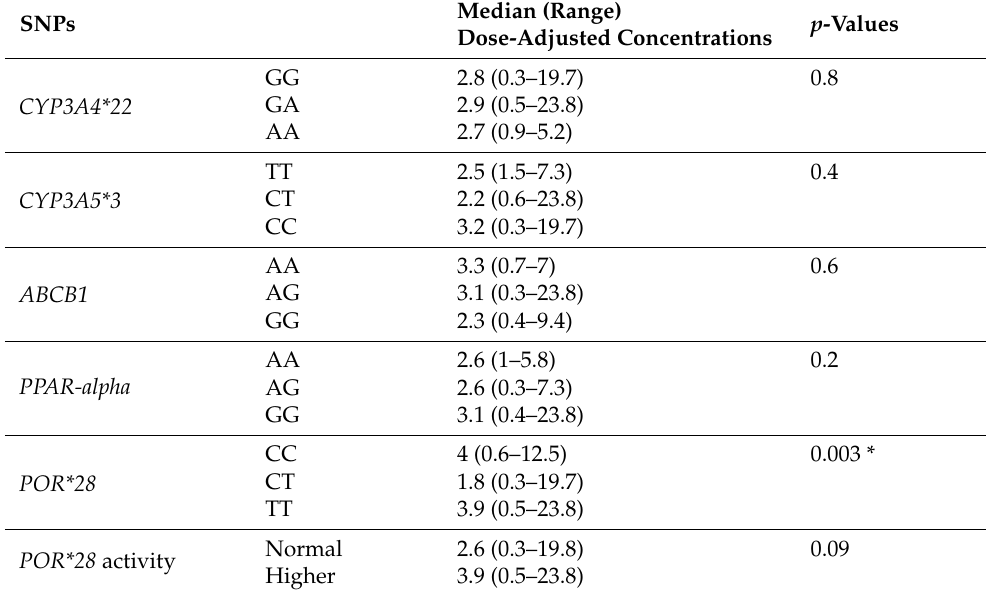
Table 4. Analysis of overall dose-adjusted concentrations with the SNPs.